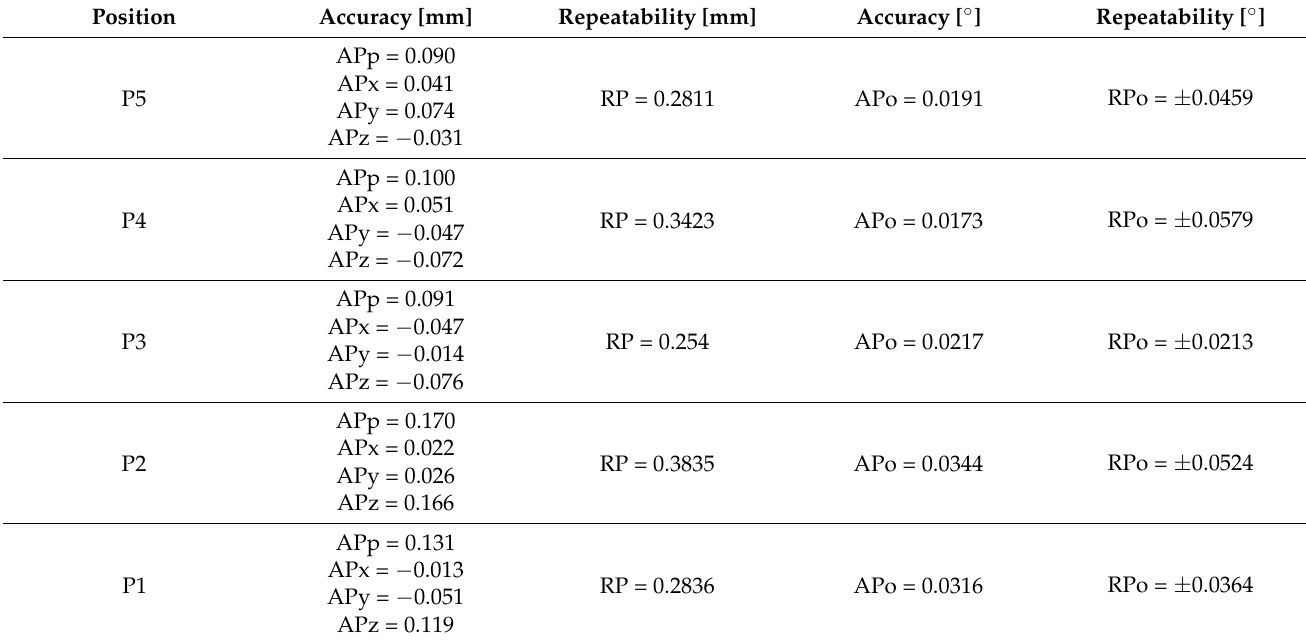
Table 6. Calculated precision and repeatability.